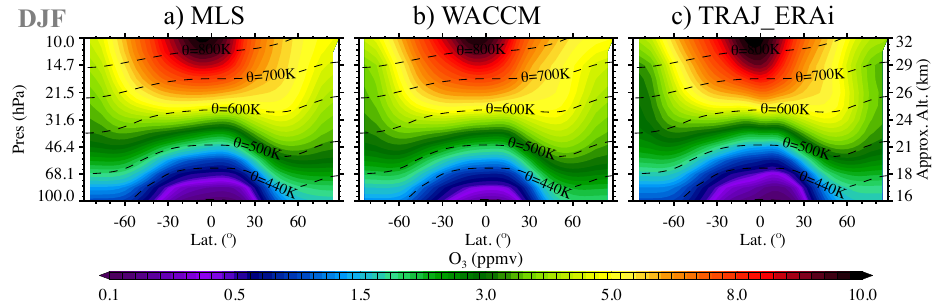
Figure 3. Trajectory modeled O 3 driven by ERAi reanalysis wind ( c , TRAJ_ERAi) in boreal winter (DJF), compared to both MLS obser- vations (a) and WACCM output (b) . Both WACCM and trajectory model results are weighted by the MLS averaging kernels. Dashed lines are potential temperature contours, demonstrating that in the lower stratosphere where transport dominates, chemical distributions roughly follow the